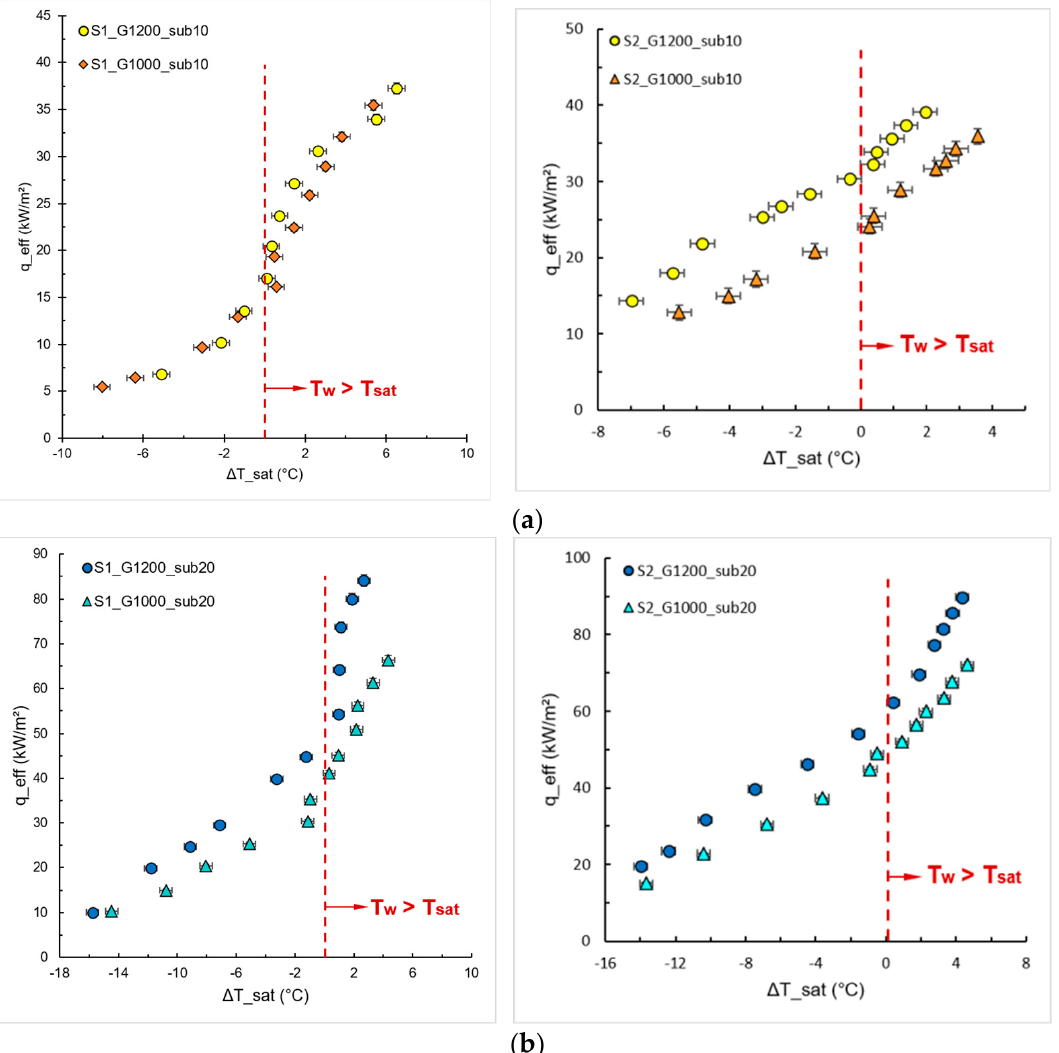
Figure 8. E ff ects of mass fl ux on the fl ow boiling heat transfer of HFE-7100. ( a ) Δ T sub = 10 °C; ( b ) Figure 8. Effects of mass flux on the flow boiling heat transfer of HFE-7100. ( a ) ∆ T sub = 10 ◦ C; Δ T sub = 20 °C. ( b ) ∆ T sub = 20 ◦